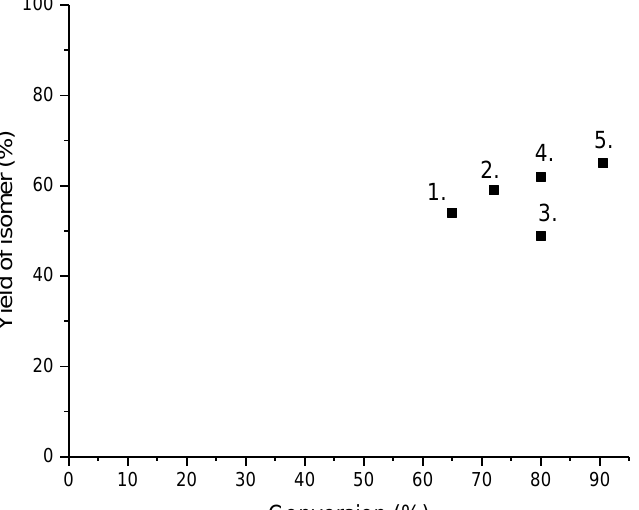
Figure 6. Yield of isomers as a function of n-dodecane conversion. Notation: 1. Pt-SAPO-11, 260 °C, H 2 /feed molar ratio of 25 [25], 2. Ni 2 P-SAPO-11 [26], 350 °C, 20 bar, WHSV 1 hr −1 , H 2 /feed molar ratio of 19, 3. Pt-ZSM-22/ZSM-23, 320 °C, 80 bar, LHSV 1 hr −1 , H 2 /feed volumetric ratio of 500 [27], 4. Pt-ZSM-22 desilicated, 280 °C, 20 bar, H 2 /feed volumetric ratio of 600, WHSV = 2 hr −1 [28] 5. Pt-Fe-ZF1, 330 °C, 20 bar, H 2 /feed volumetric ratio of 600, LHSV 2 hr −1 [29].